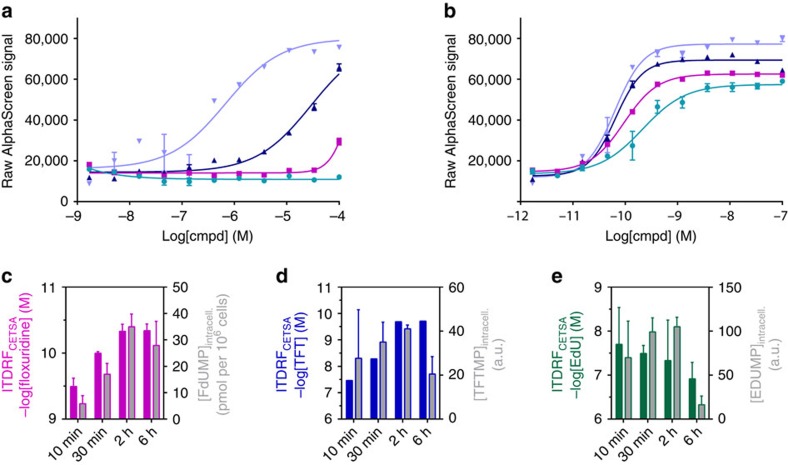
Time dependence of target engagement and correlation with the appearance of intracellular active metabolites.(a) Representative ITDRFCETSA curves for 5-fluorouracil as a function of preincubation time in K562 cells; 10 min (green circle), 30 min (magenta square), 2 h (blue upwards triangle) and 6 h (lavender blue downwards triangle). The solid lines represent best fits to a saturation binding curve function to yield ITDRFCETSA values for half-maximal stabilization of TS. Data are provided as the average and s.e.m. from experiments done in quadruplicate at a single test occasion. (b) The corresponding ITDRFCETSA data for floxuridine. (c) Half-maximal stabilization of TS (magenta) and intracellular concentration of FdUMP (grey) as a function of preincubation time with floxuridine. The CETSA data are presented as the average and range from two independent experiments. The LC–MS/MS data are provided as the average and s.e.m. from experiments done at three different occasions. (d) The corresponding data for TFT (blue) and TFTMP (grey). (e) The corresponding data for EdU (green) and EdUMP (grey).